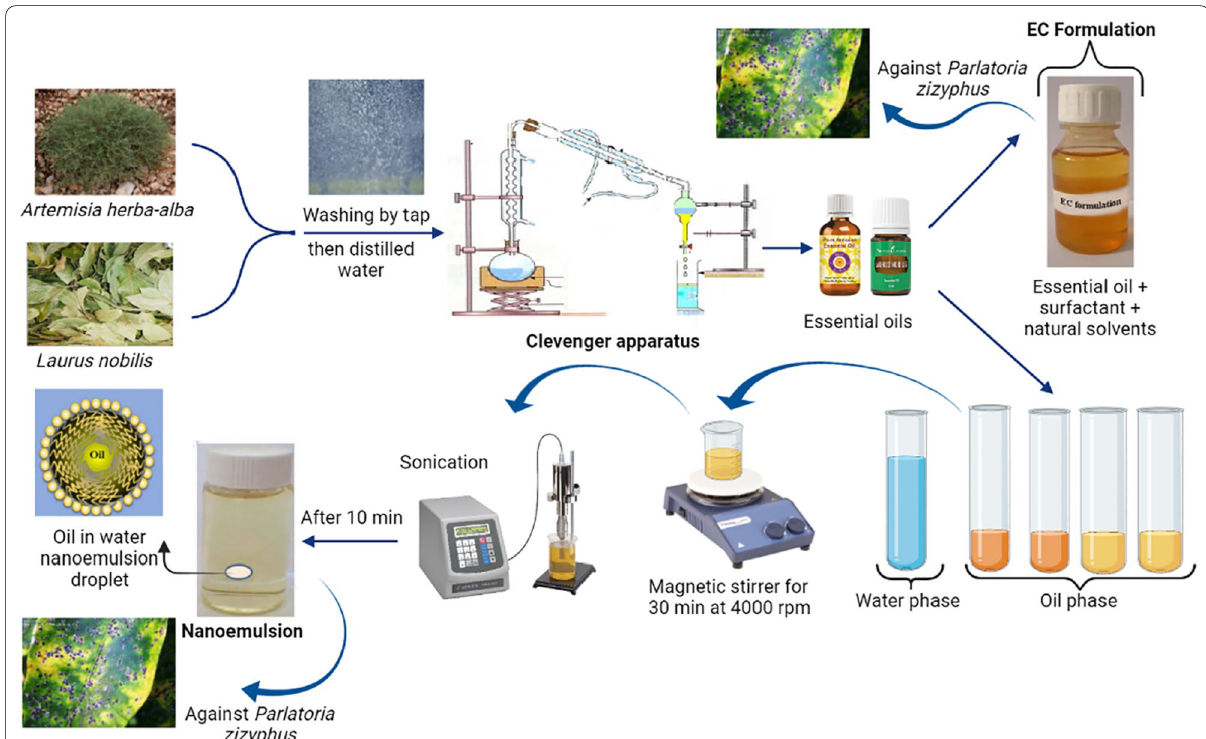
Fig. 1 Preparation of emulsifiable concentrate and nanoemulsion formulations based on essential